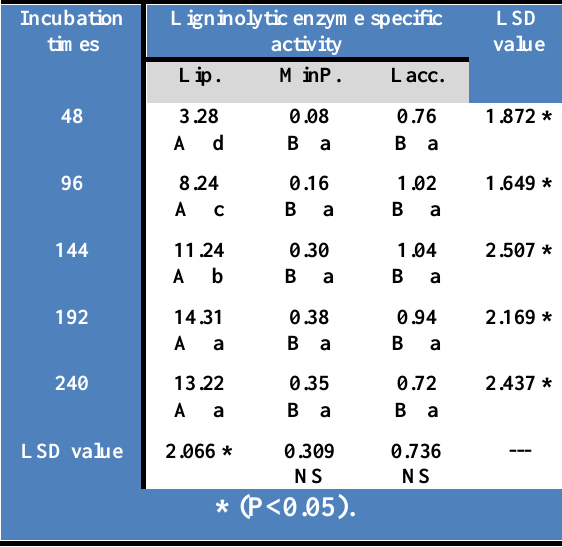
Table, 4: Effect of Incubation times and enzymes production in specific activity